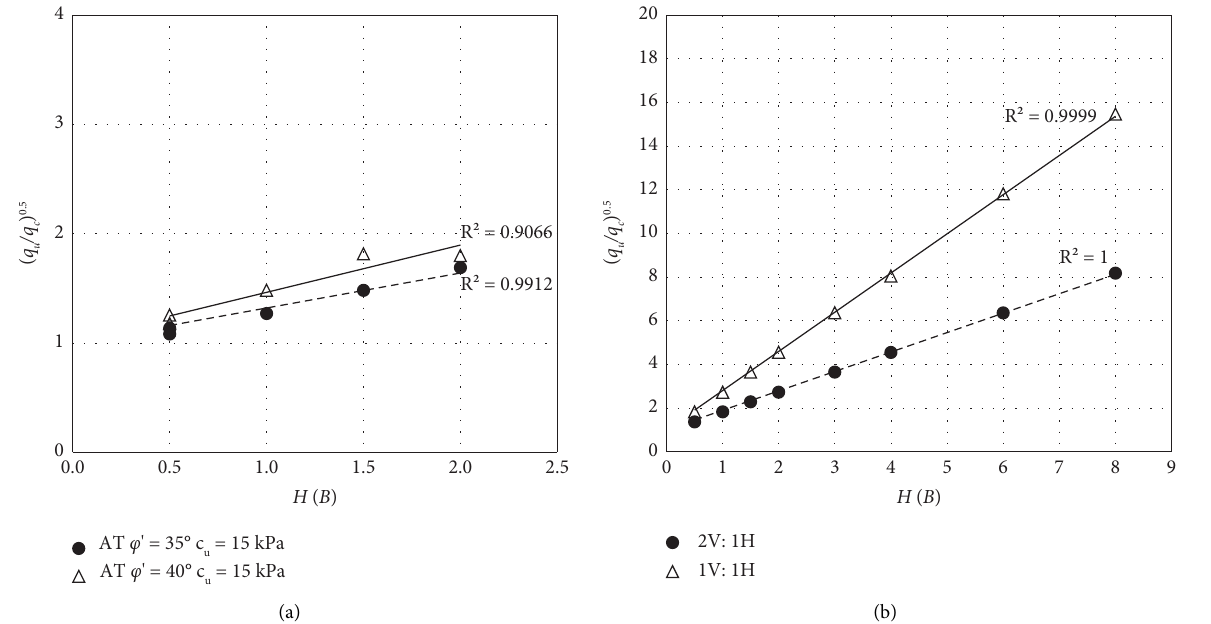
Figure 9: ( q q ) 0 . 5 versus H/B for an unstabilised granular layer (data source: (a) Gupta et al. [38] and (b) load spread method). u / c